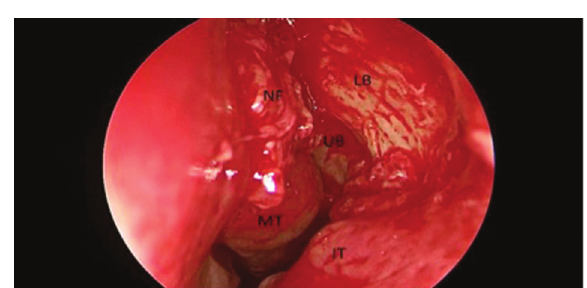
Nasal mucosal flap and exposure of lacrimal bone :freer elevator used to elevate mucosal flap covered lacrimal bone and extent posteriorly to the attachment of uncinate process. IT: inferior turbi- nate, LB: lacrimal bone, MT: middle turbinate, NF: nasal flap, UP: uncinate process.